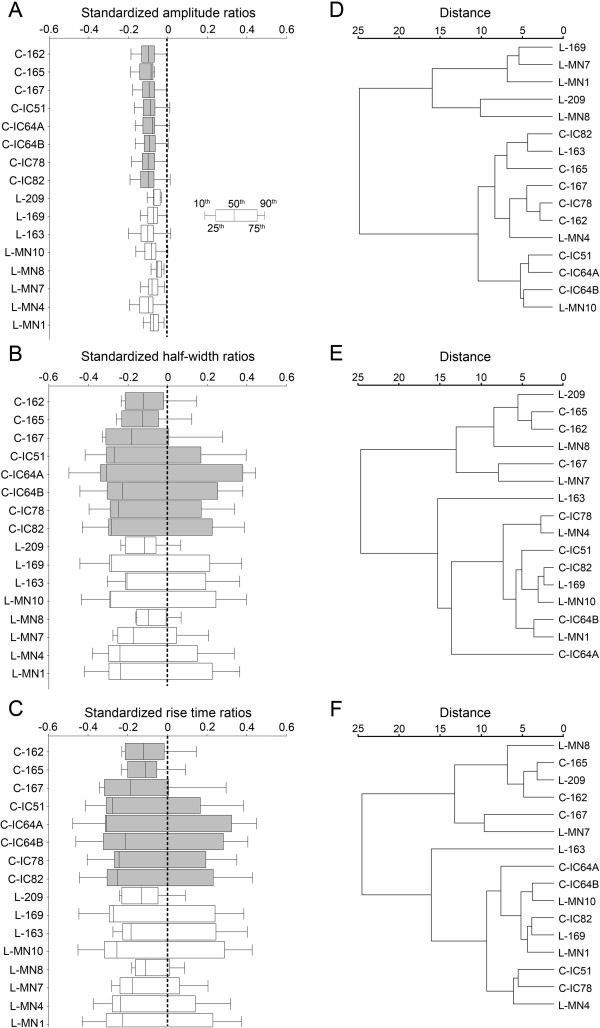
Propagation of voltage transients. Somatic to dendritic ratios of PSP amplitudes, half-widths and rise times were computed for each dendritic compartment, ratios were then weighted by the area of the compartments and distributions were standardized. Percentiles are shown as box plots (see insert) for amplitudes (A), half-widths (B) and rise times (C) respectively (boxes for cervical MNs are shaded). These percentiles were then weighted relative to the median and used as descriptors in cluster analysis. Dendrograms of cluster formations (using Pair group method) were based on ratios of amplitudes (D), half-widths (E) and rise times (F). A control, or middle level of synaptic background activity (Rmd = 20000 Ωcm2) was assumed in all cases shown. Labels starting with letters L and C stand for cervical and lumbar MNs respectively. The weighting factors for percentiles were: 0.33 for the 10th and 90th percentiles and 0.67 for the 25th and 75th percentiles.